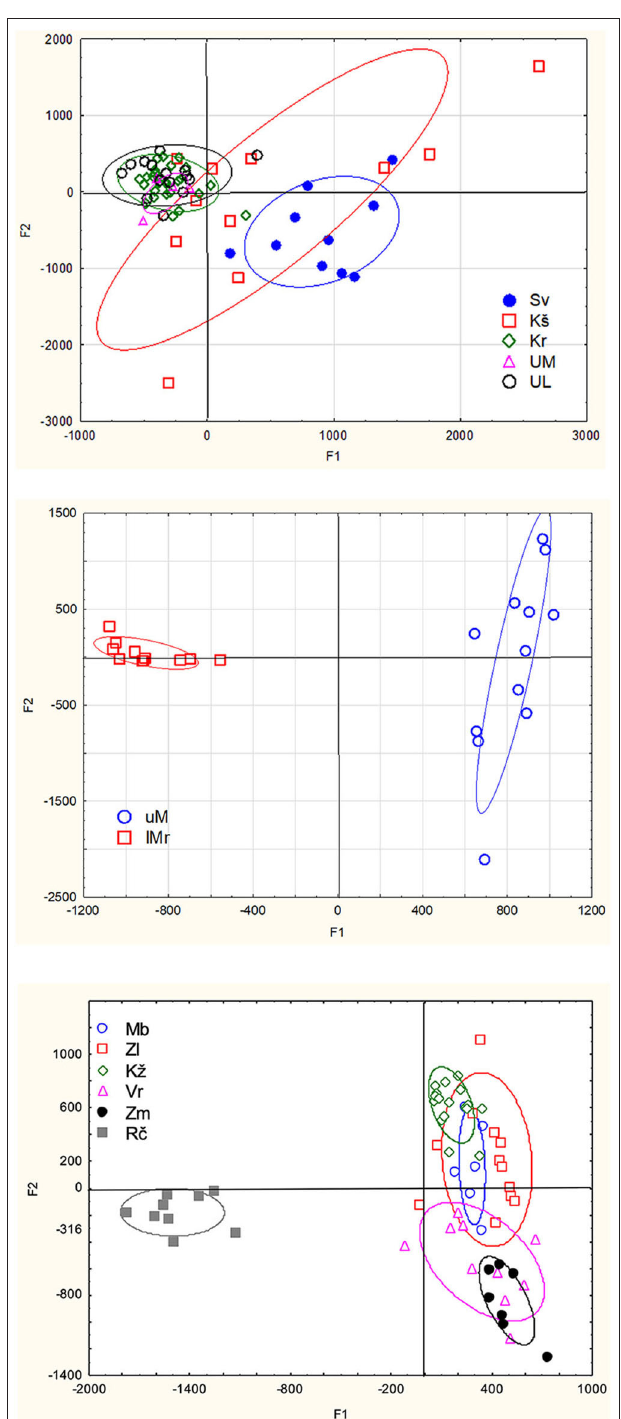
FIGURE 2 | Correspondence analysis of brown trout populations from the Una River catchment (top), Mrtvica River (in the middle), and streams in the Iron Gate Gorge area (bottom) (Sv, Svetinja River; Kš, Krušnica River; Kr, Krka River; UM, Una River at Martinbrod; UL, Una River at Loskun; uM, upper Mrtvica River; lM, lower Mrtvica River; MB, Mala Boljetinska River; Zl, Zlatica River; KŽ, KoŽica River; Vr, Vratna River; Zm, Zamna River; Rˇc, Reˇcka River).